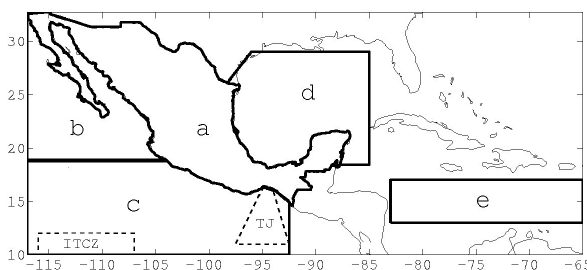
Fig. 1. Study regions: (a) Continental Mexico, (b) Subtropical Pa- cific, (c) Tropical Pacific, (d) Gulf of Mexico, (e) Caribbean Sea. The areas indicated by dashed lines correspond to the Tehuantepec Jet and ITCZ sub-regions that are discussed in Sect.